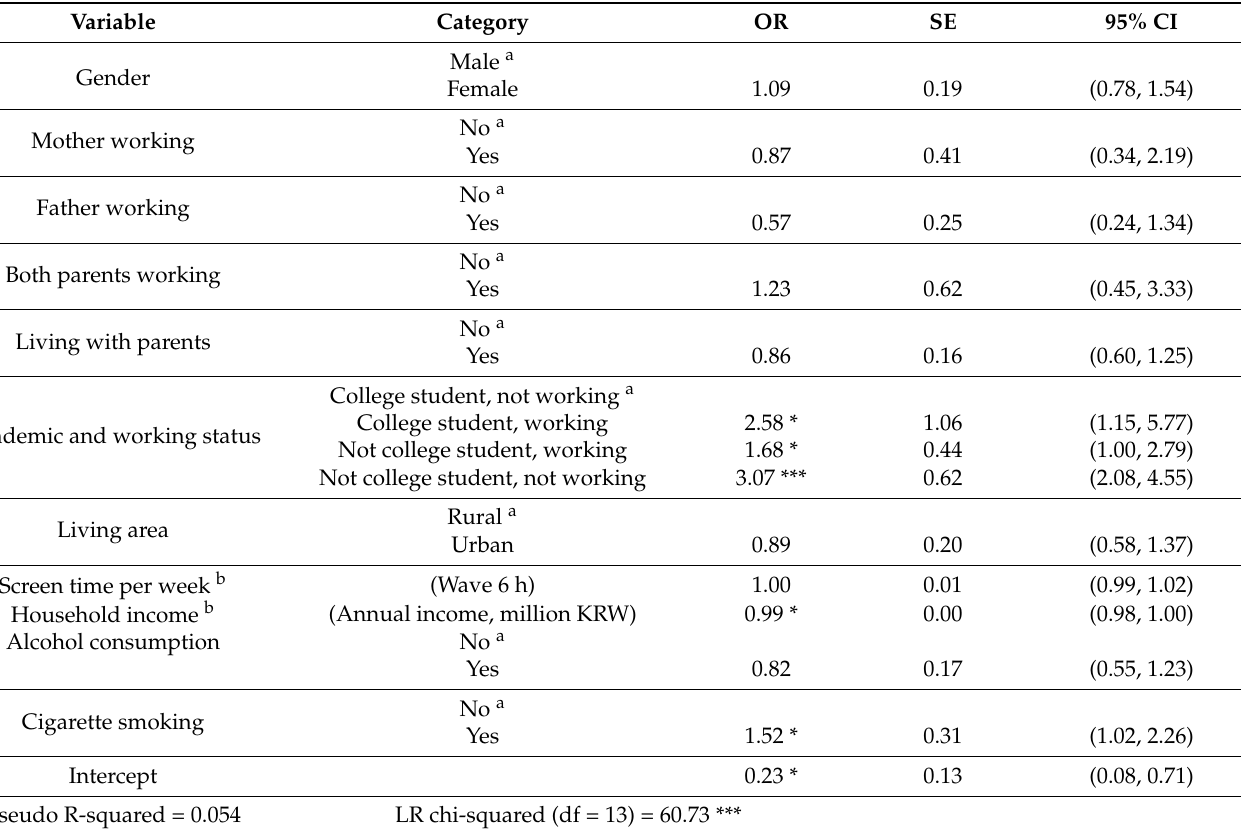
Table 2. Logistic regression analysis to investigate factors associated with oversleeping ( n =